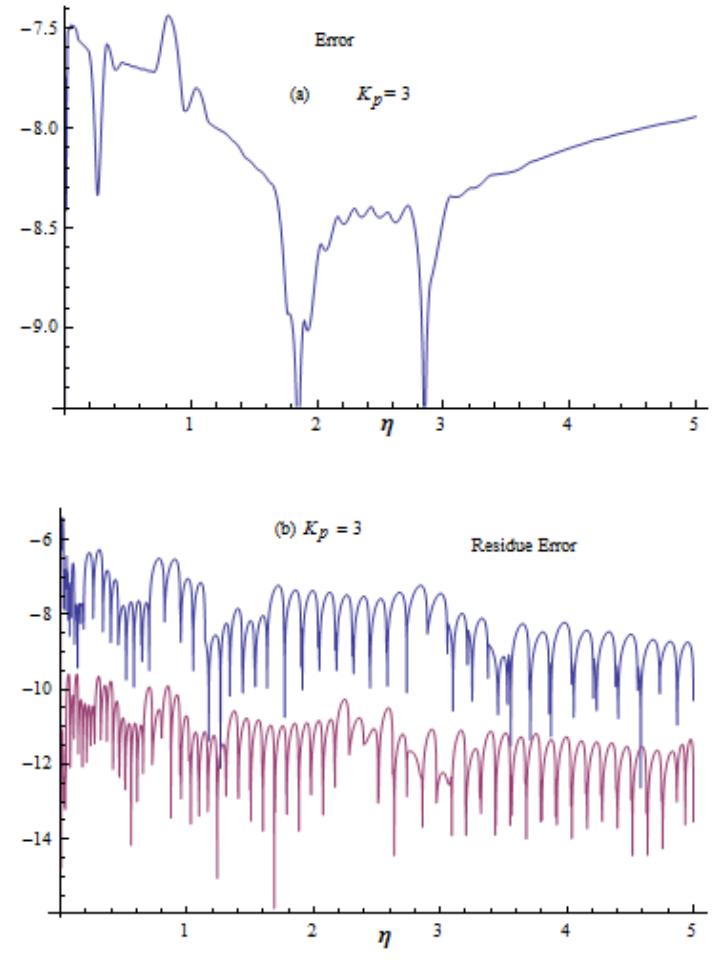
Figure 3. Error ( a ) and residue error ( b ) for 𝐾 𝑝 = 3. The blue line represents the average residue error and the red line represent the total average residue error in ( b ).